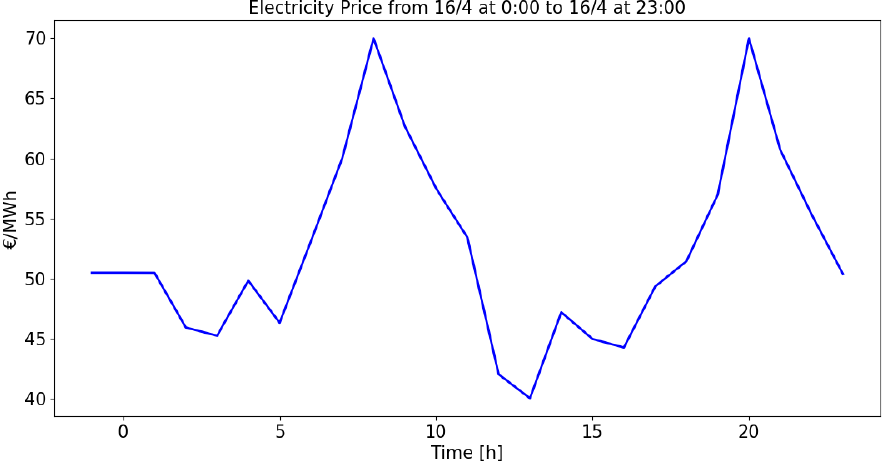
Figure 4. Unit prices of electricity for one day in